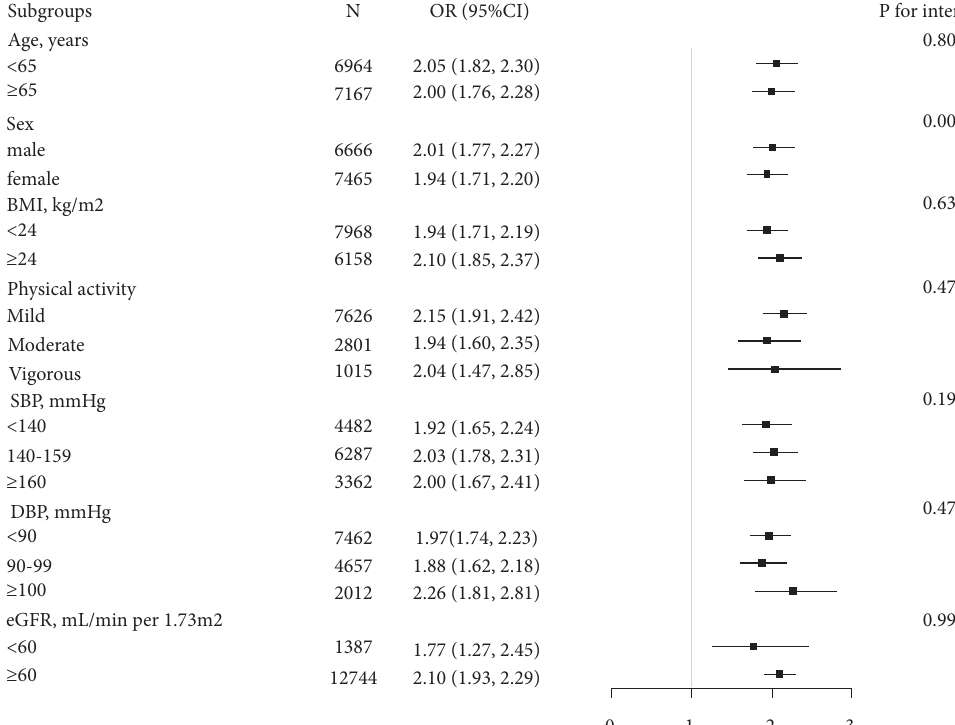
Figure 3: Subgroup analysis of the association between the TyG index and hyperuricemia. Adjusted for age, gender, education, smoking, drinking, BMI, waist circumference, physical activity, diabetes, eGFR, HDL-C, LDL-C, serum homocysteine, antiplatelet drugs, antihy- pertensive drugs, SBP, and DBP. The BP control maintained was defined as SBP < 140mmHg and DBP <